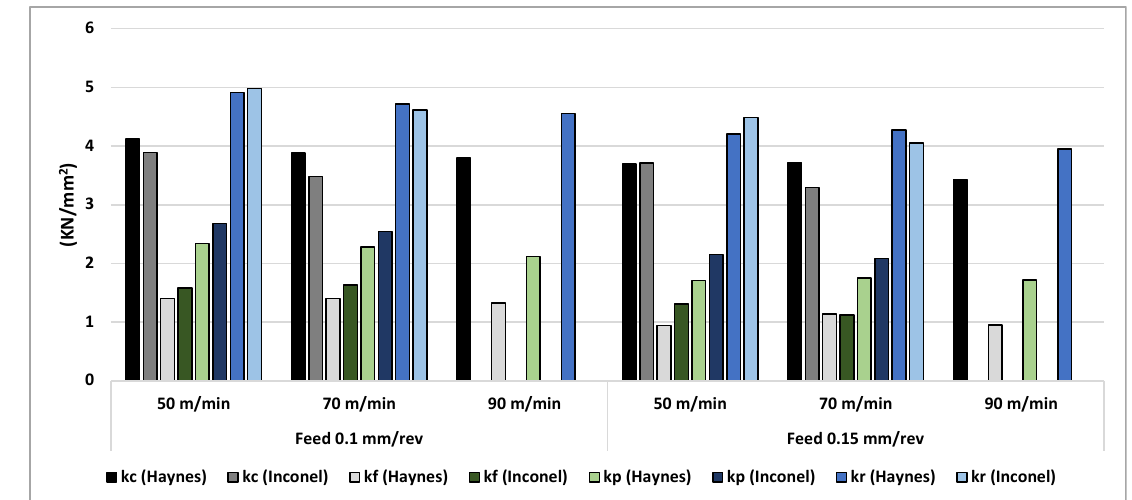
Figure 4. Initial specific cutting forces for both Haynes [36] and Inconel [38] under conventional pressure.